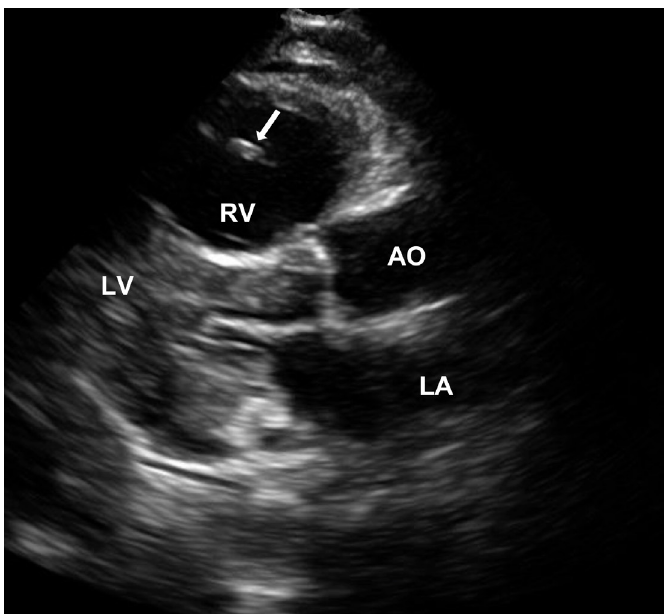
Figure 2. Parasternal long view of the heart with the free-floating clot (arrow) visualized in the dilated right ventricle